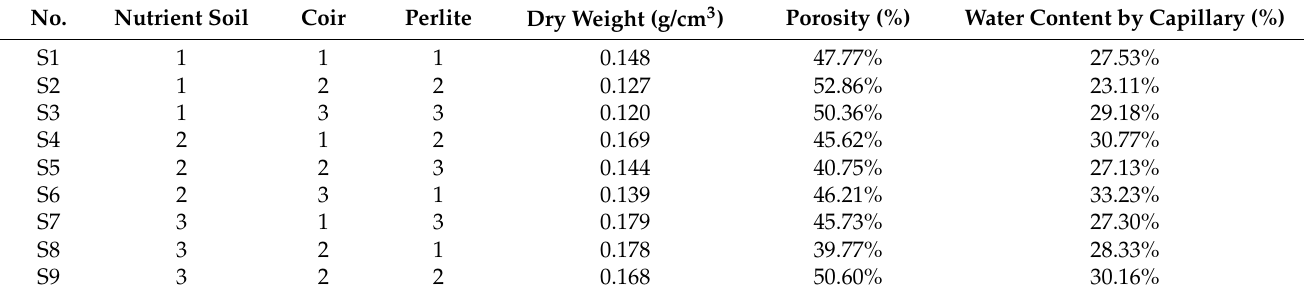
Table 1. Proportioning and physicochemical properties of 9 mixed